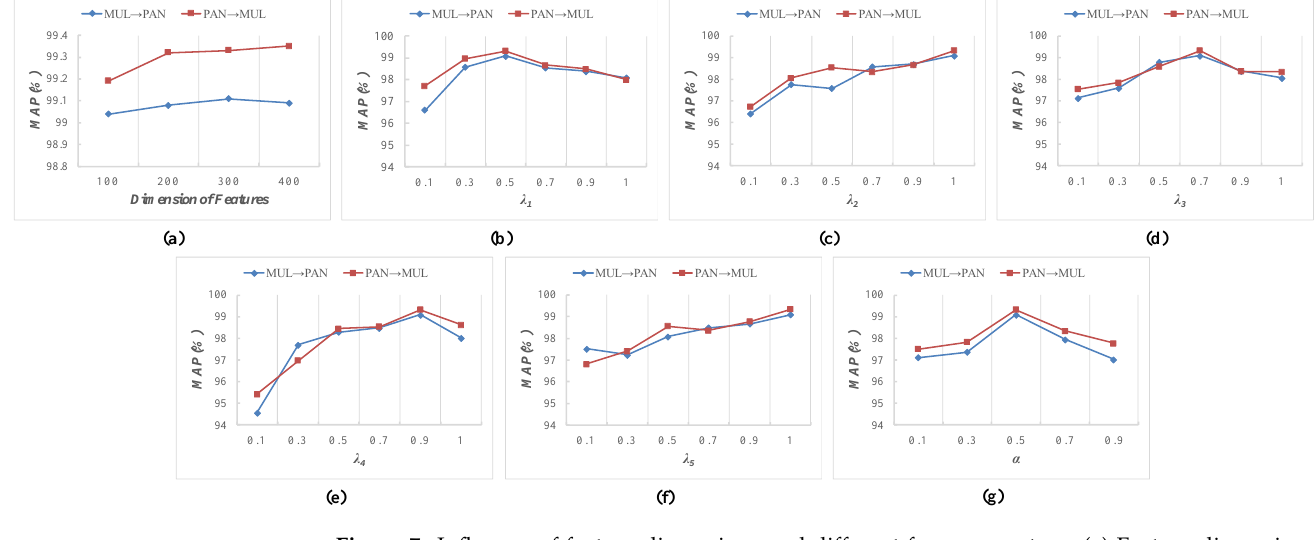
Figure 7. Influence of feature dimensions and different free parameters. ( a ) Feature dimensions. ( b ) λ 1 . ( c ) λ 2 . ( d ) λ 3 . ( e ) λ 4 . ( f ) λ 5 . ( g ) α